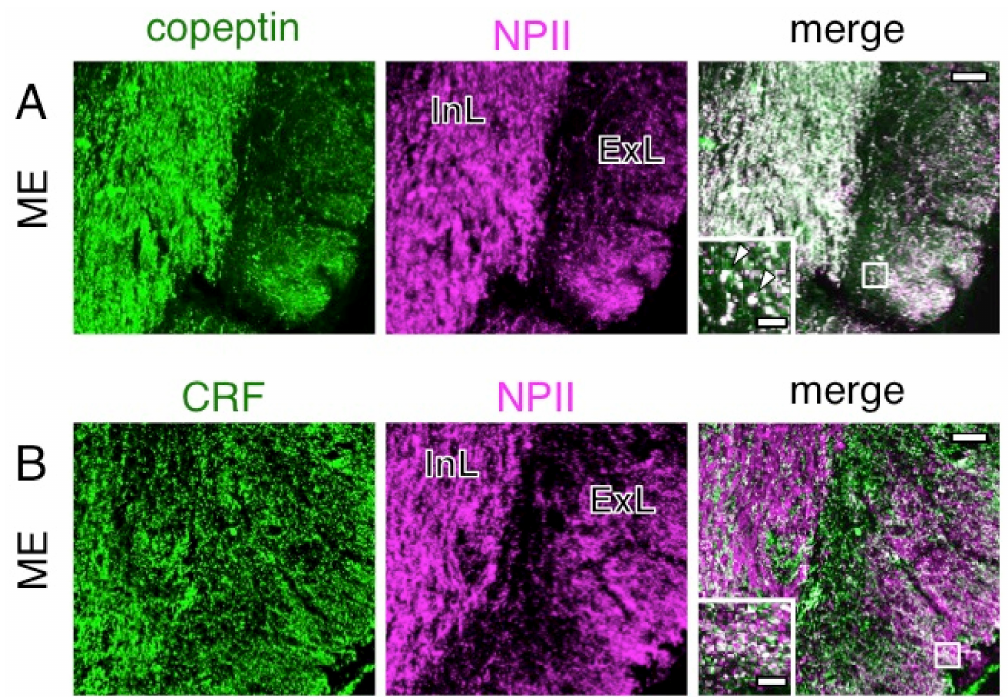
Figure 9. Double-label immunofluorescence for copeptin ( A ) or corticotrophin-releasing factor (CRF) ( B ) and vasopressin- associated neurophysin (NPII) in the macaque median eminence (ME). Immunoreactivity against copeptin ( A ; green) or CRF ( B ; green) and NPII (magenta) is merged in each right-hand panel (overlap; white). The outlined areas in merged images are enlarged. Arrowheads in ( A ) indicate tissue doubly immunopositive for copeptin and NPII. Scale bars, 50 µ m, and 10 µ m in enlarged images. InL, internal layer of the ME; ExL, external layer of the ME.